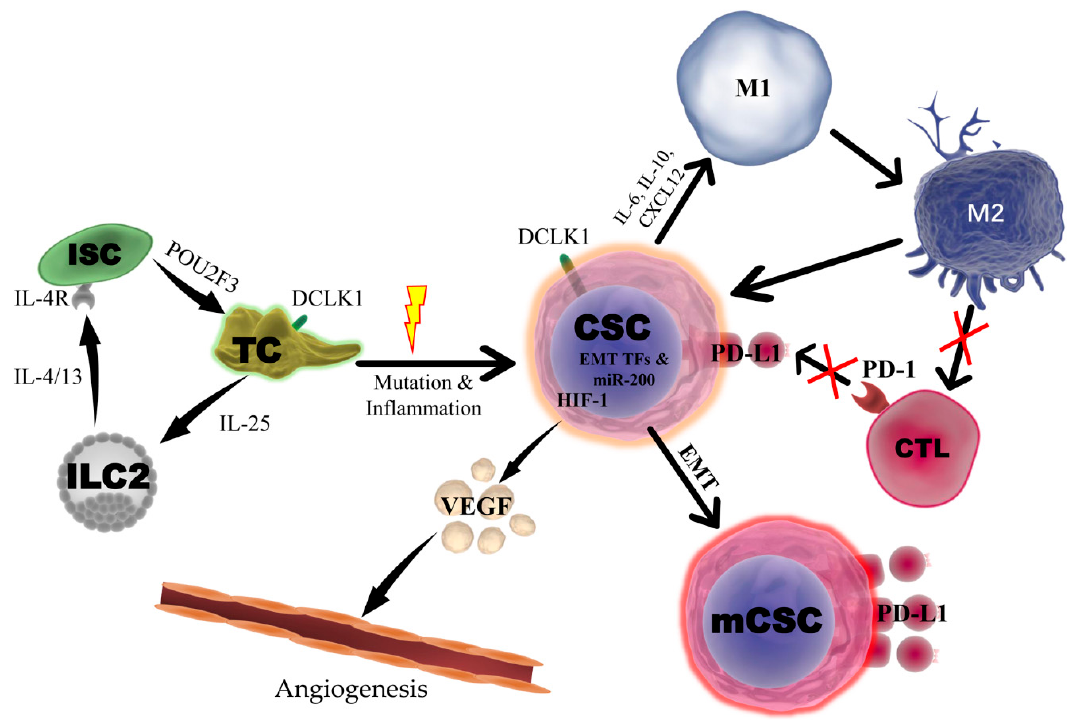
Figure 1. Potential Role of DCLK1 and DCLK1+ Cells in the Intestinal Tumor Microenvironment. DCLK1+ tuft cells (TC) will recruit innate lymphoid type-2 cells (ILC2) by secreting IL-25 which in turn reprograms intestinal stem cells (ISC) through IL4/13-IL4R signaling to express transcription factor POU2F3 leading to TC hyperplasia. In the presence of mutation and inflammation, DCLK1+ TCs can be converted to cancer stem cells (CSC) and initiate a tumor. Under hypoxia, DCLK1+ CSCs may induce angiogenesis by upregulation of HIF-1 and secretion of VEGF. Furthermore, DCLK1+ CSCs promote EMT via the miR-200 family leading to metastatic CSCs (mCSC) with high levels of PD-L1. DCLK1+ CSCs further regulate the immune tumor microenvironment by polarization of M1 macrophages towards an M2 status by secreting IL-6, IL-10 and CXCL12, which leads to inhibition of T-cell proliferation and activation. DCLK1-positive CSCs also express programmed death ligand 1 (PD-L1) expression to inhibit CD8/PD1++ CTL function.